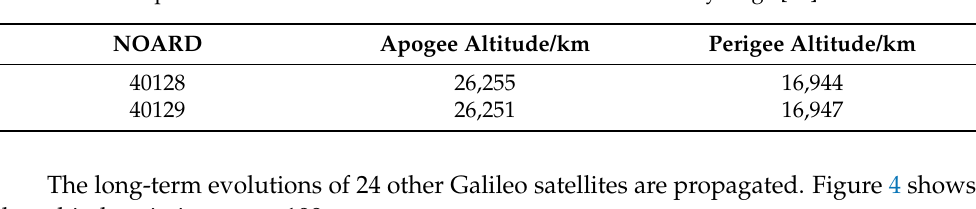
Table 2. Orbital parameters of the upper stage numbered 40,130 [22].